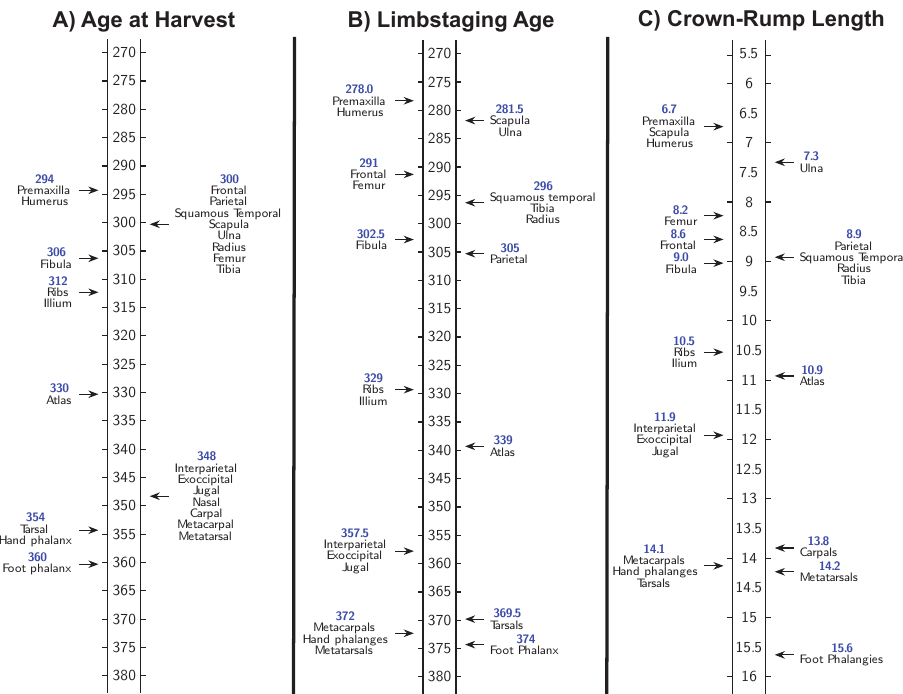
Figure 7. Timeline of ossification center appearance marked by osteoblast differentiation (expression of Osx) generated using Osx-GFP mice ordered according to: ( A ) age at harvest; ( B ) limbstaging age; and ( C )